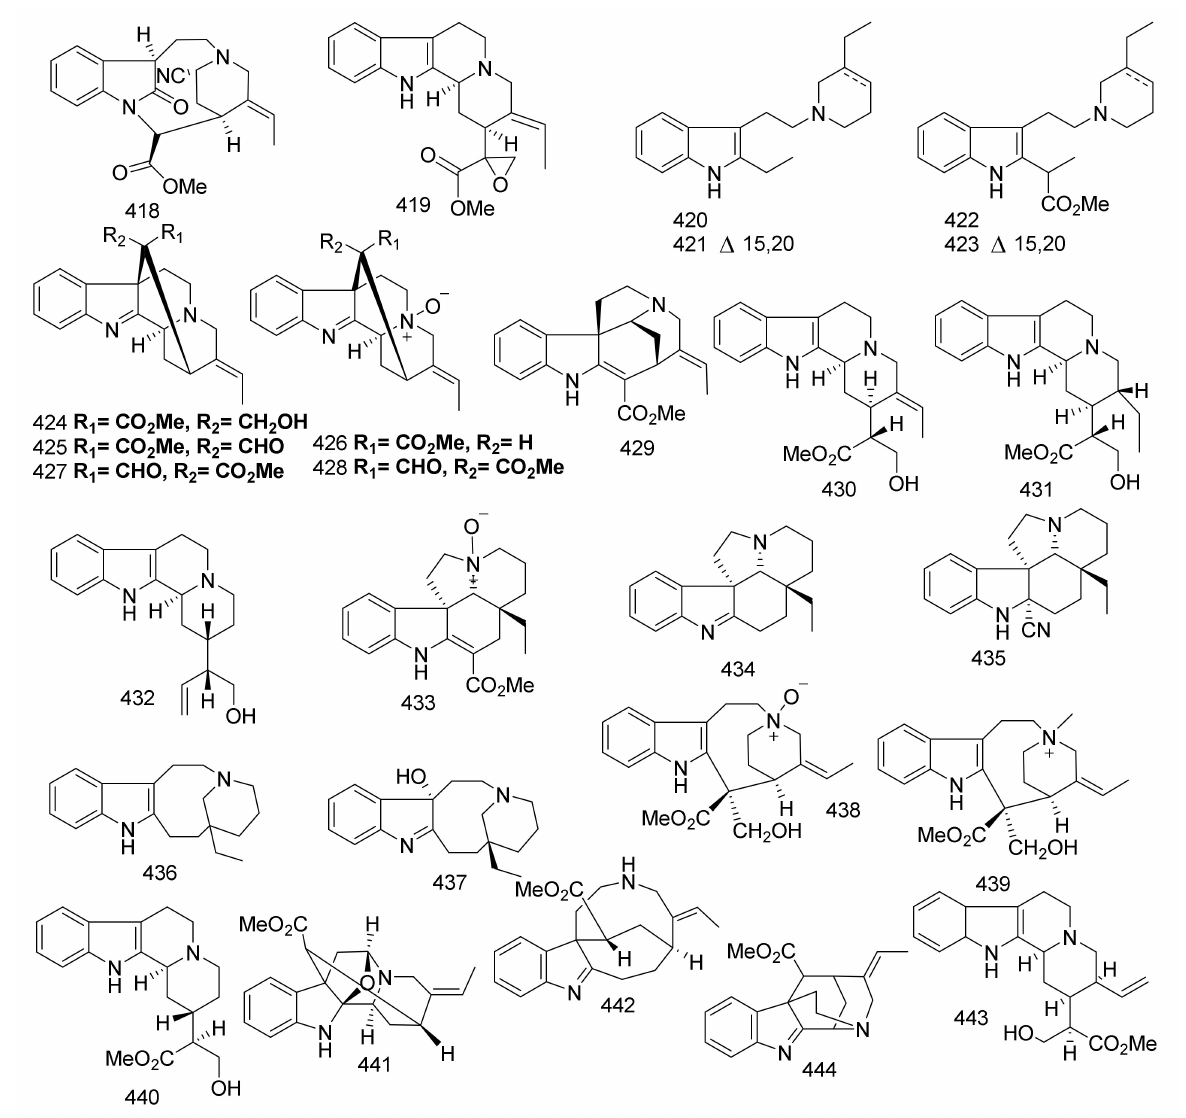
Figure 33. Compounds 418 – 444